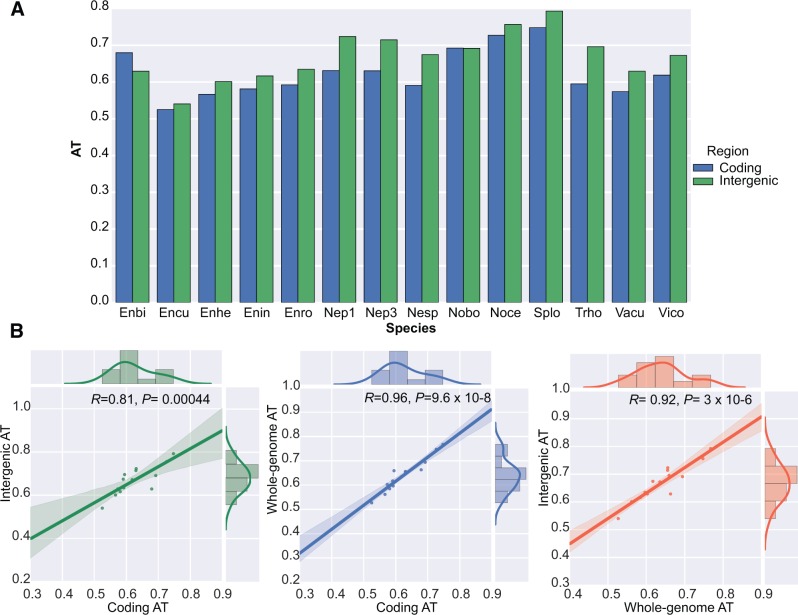
An evolutionary force favors lower AT content in microsporidian genomes. (A) In all microsporidian genomes analyzed except that of E. bieneusi, the AT content of intergenic regions exceeds that of coding sequences. This trend is significant across the whole dataset (P = 0.001199, paired t-test), as well as within each individual genome (P < 10–24 for all comparisons; see additional file 3, Supplementary Material online for details). These data suggest selection for more moderate nucleotide compositions in coding sequences, perhaps as a result of functional constraints. (B) Correlations between coding, intergenic and whole-genome AT content across the complete set of published microsporidian genomes. All three variables are highly and significantly correlated; in particular, the correlation between the AT content of coding and intergenic regions within each genome suggests that the selective pressure against AT extends to intergenic regions. This pattern might be explained by variation in the extent of biased gene conversion, which in eukaryotes tends to increase GC content, across the Microsporidia. The correlations reported here are robust to the underlying microsporidian phylogeny, as assessed by phylogenetic generalized least squares regression [P = 0.00049, P = 5.3 × 10−7, P = 6.9 × 10−5 for the three comparisons in (b), respectively].